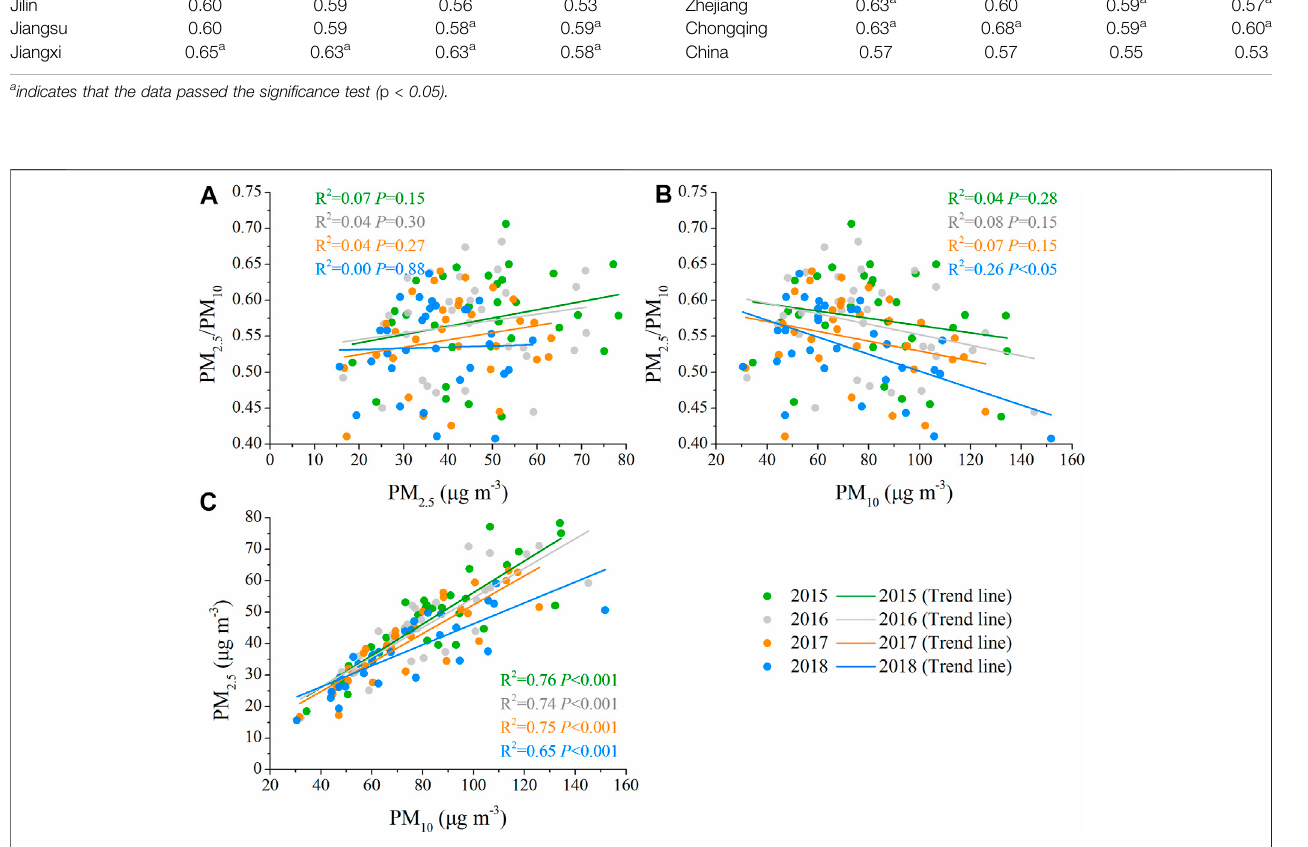
FIGURE7| Thescattered plotsamongPM 2.5 ,PM 10 ,and PM 2.5 /PM 10 ratios attheprovinciallevelduringthestudyperiod.Thegreen, gray,orangeand bluecolors are for data in year 2015, 2016, 2017 and 2018, respectively. (A – C) represent the correlation between PM 2.5 /PM 10 and PM 2.5 , PM 2.5 /PM 10 and PM 10 , and PM 2.5 and PM 10 ,